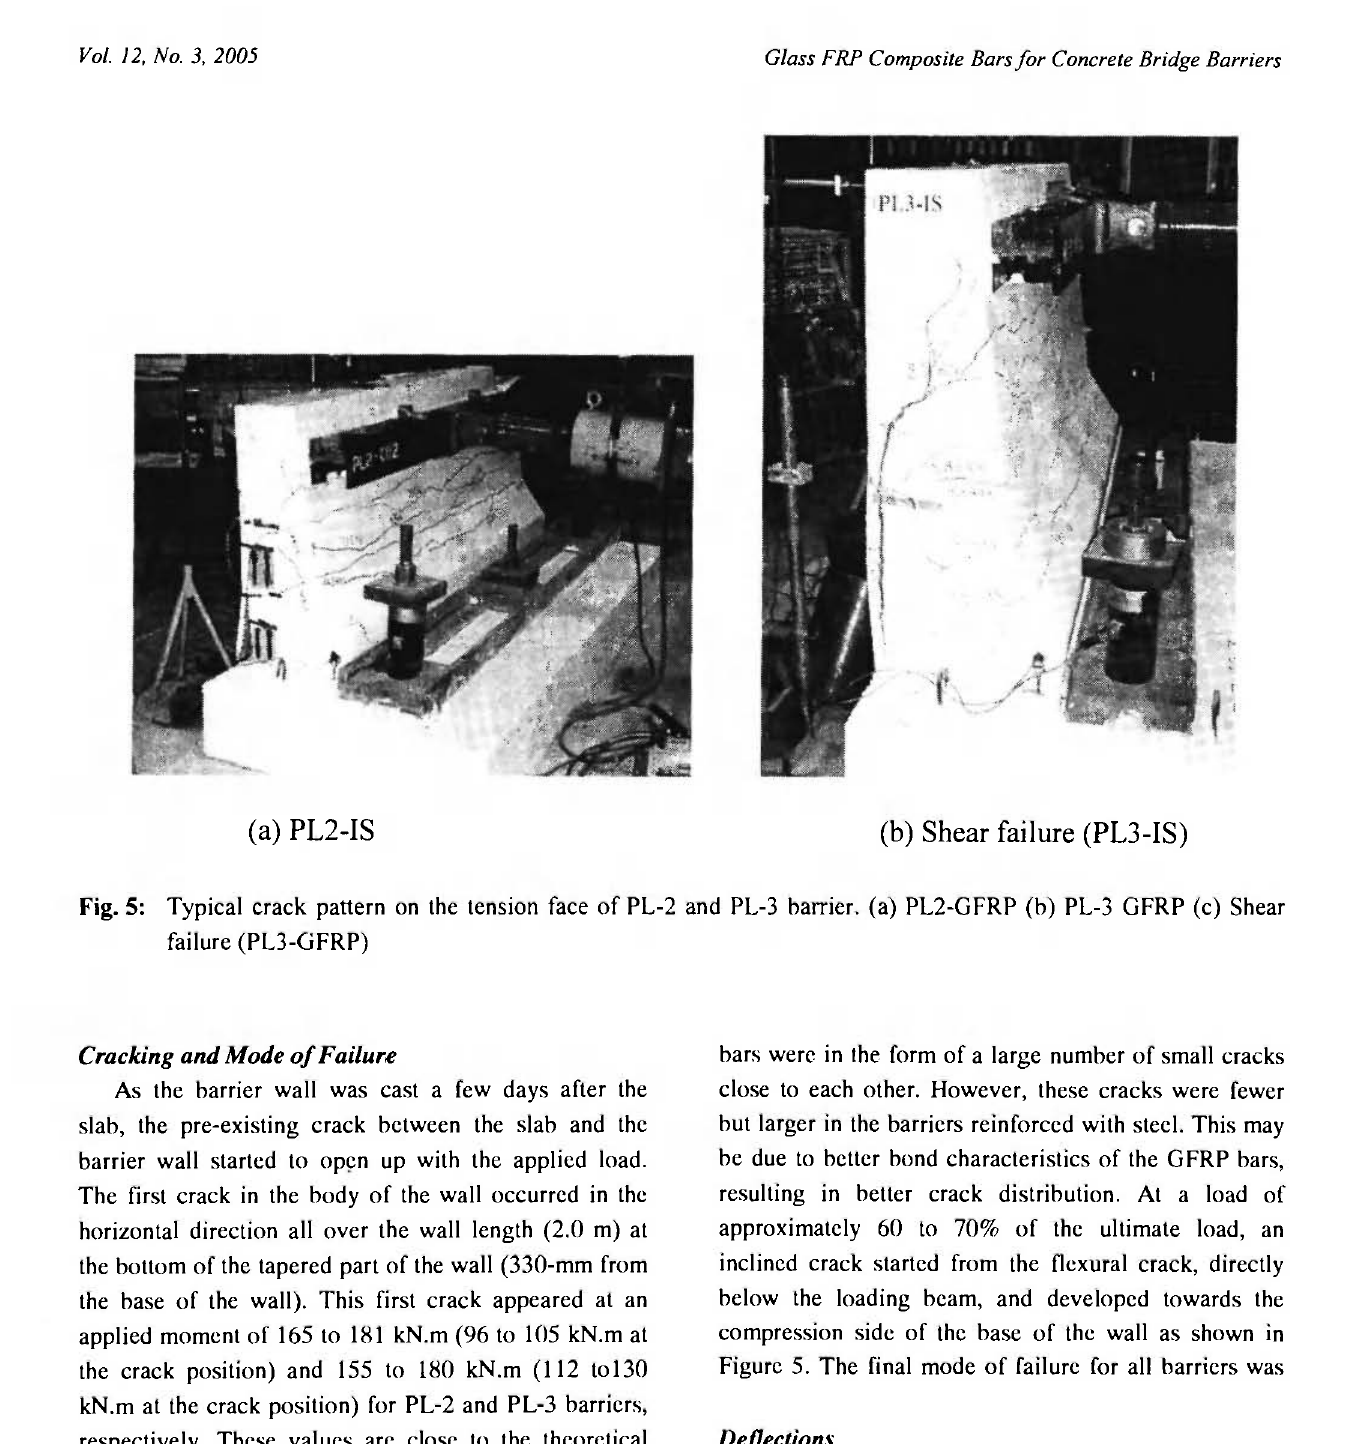
Deflections Figure 6 shows the applied moment versus horizontal deflections measured at the top back face of PL-2 and PL-3 barriers, respectively. For each series, the deflection characteristics were very similar up to the cracking moment (100 kN.m to 130 kN.m). As the load increased above the cracking moment, the measured deflection for barriers reinforced with GFRP bars was larger than their counterparts reinforced with the